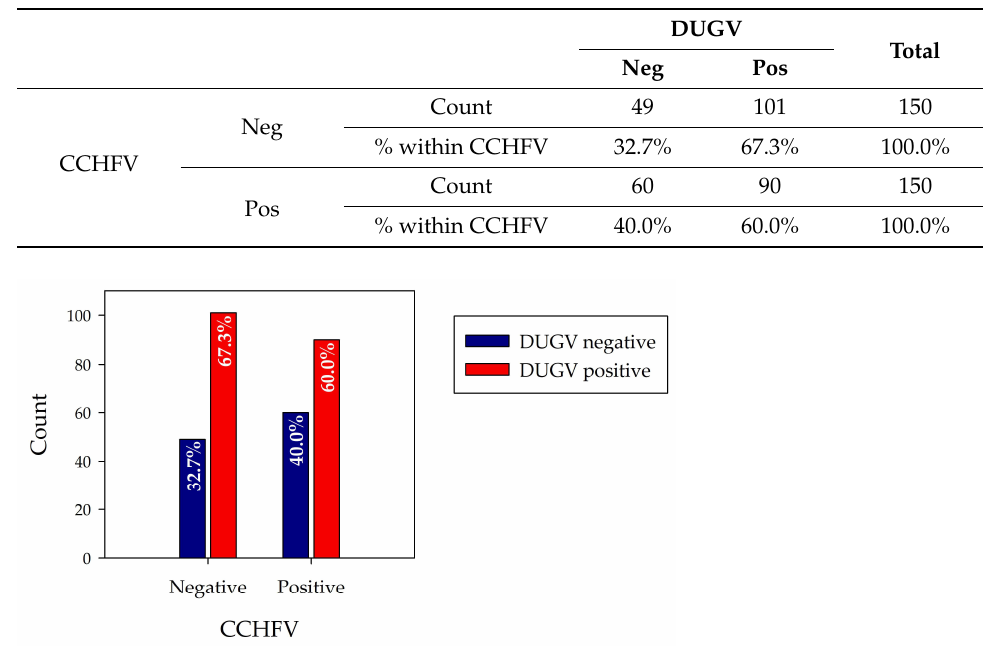
Figure 4. Cross-reactivity N protein-based ELISAs: The percentage of DUGV antibody-positive sera is slightly lower for the CCHFV seropositive samples, indicative of good serological discrimination of DUGV and CCHFV antibodies via ELISA.